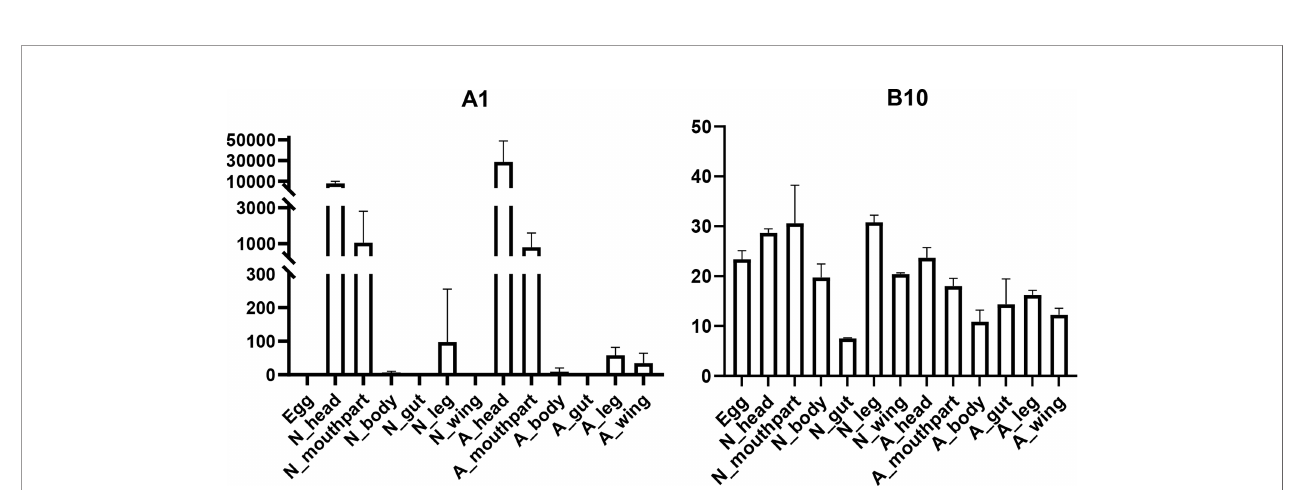
FIGURE 5 | Expression patterns of A1 and B10 in different tissues by transcriptome analysis. The vertical bars indicate standard errors of the mean (n =